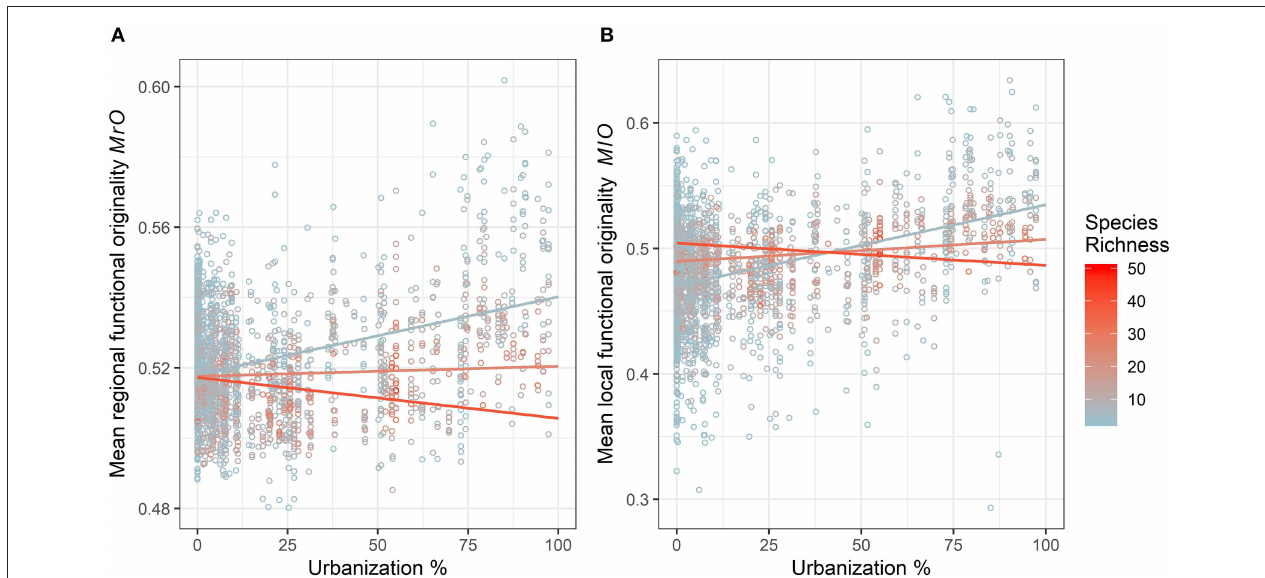
FIGURE 3 | Variation in (A ) mean regional functional originality and (B) mean local functional originality (local functional diversity) according to the percentage of urbanization within a 1 km ² grid cell (grid cell corresponds to the Vigie-flore protocol) and species richness with the complete species dataset (natives and non-natives). One data point represents one species plot. The colors represent a scale of species richness (SR) going from blue for low SR (minimum of 3 species) to red for high SR (maximum of 50 species). Colored curves represent the estimated trends of an interaction between urbanization and SR for 5 (blue), 25 (salmon), and 40 (red) species retrieved from the mean originality GLMM models.